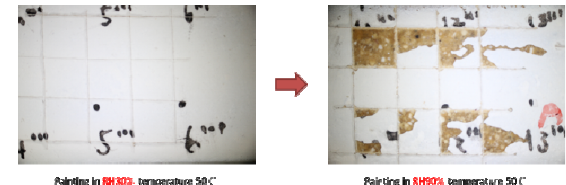
Figure 10. Painting peel off status in different RH in 50 ℃